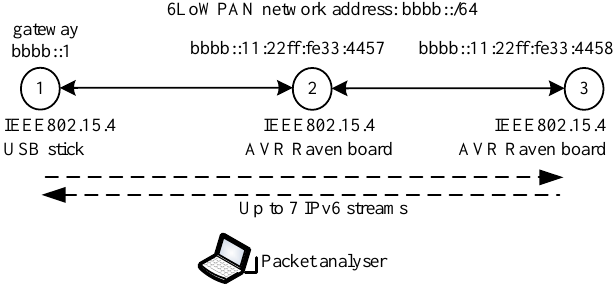
Figure 6. Simple two-hops Wireless Sensor Networks (WSN).